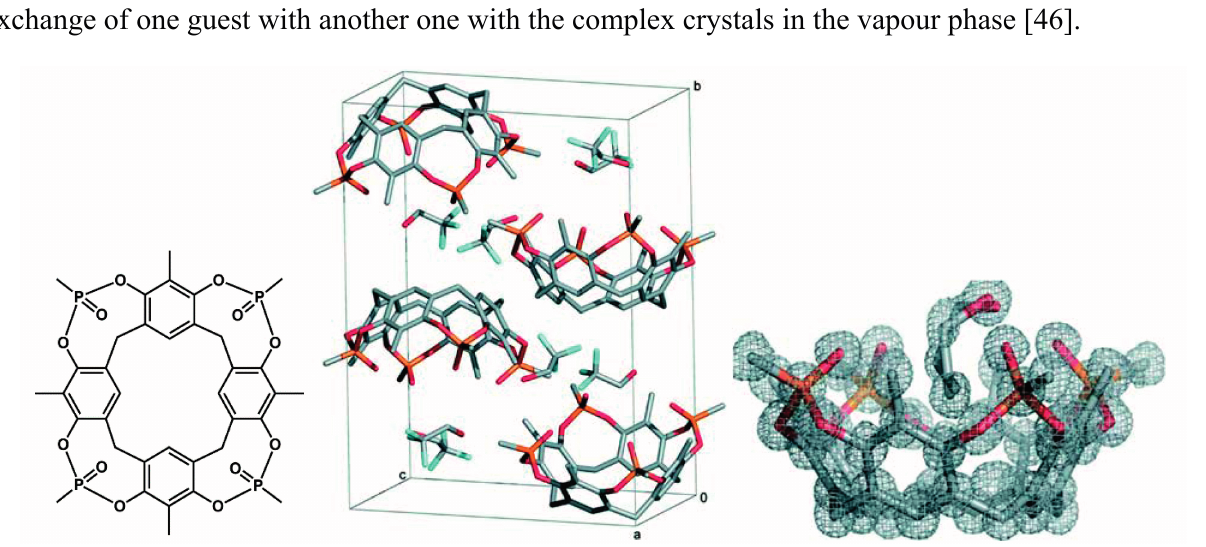
Figure 11. Example of a crystal of a resorcarene cavitand, containing co-crystalizing trifluorethanol, which forms isomorphous structures with a series of linear alcohols; the refined structure with e.g., n- propanol as ligand shows the relevant electron densities. Reprinted from [44] with permission of the Royal Society of